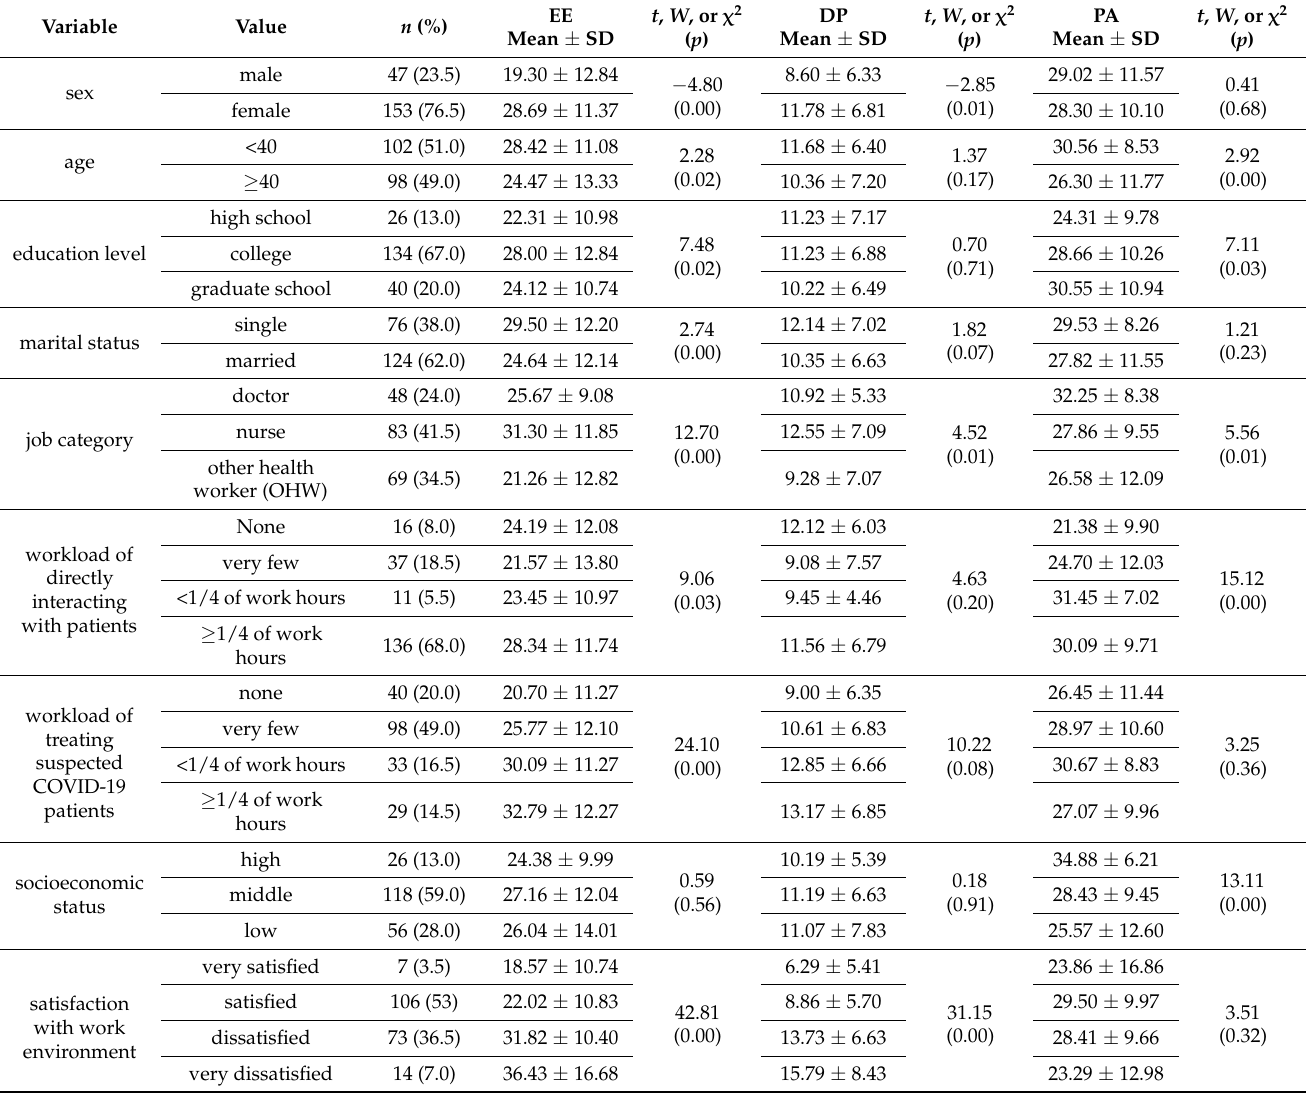
Table 1. General characteristics, other variables, and differences in COVID-19-related burnout ( N = 200).